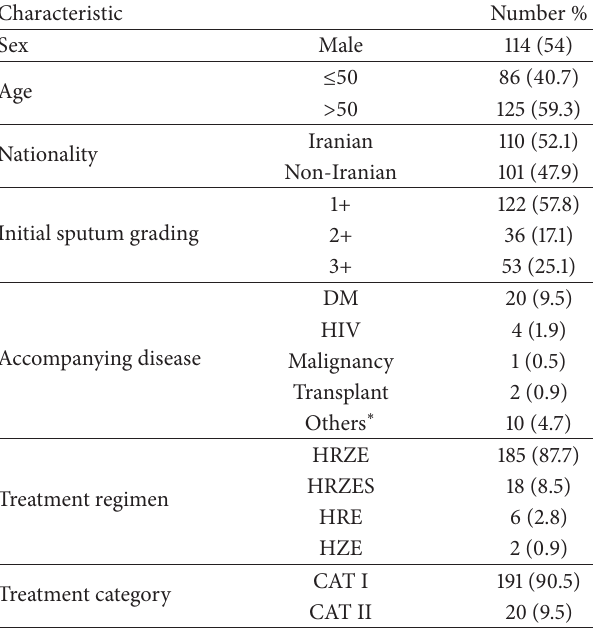
Table 1: Comorbidities and demographic and bacteriological vari- ables of sputum smear positive pulmonary tuberculosis patients in Yazd ( 𝑛 = 211 ).